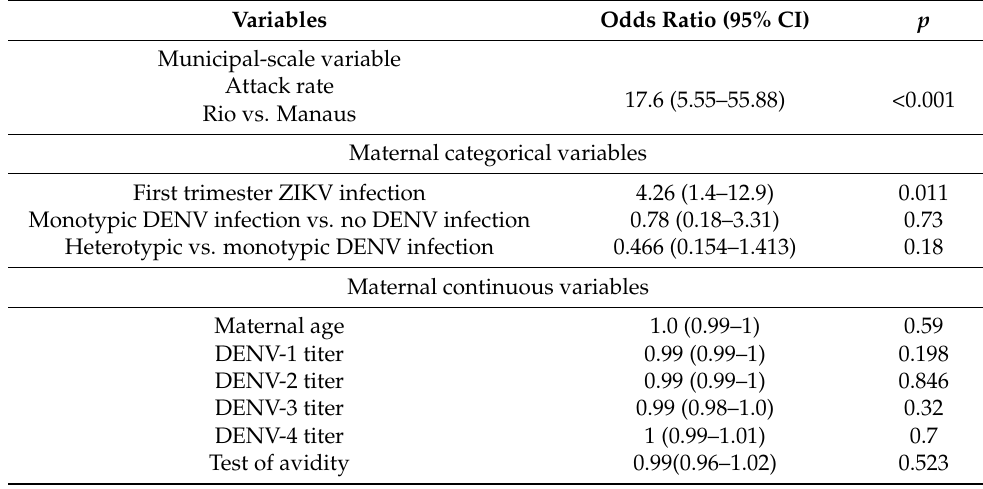
Table 4. Multivariate logistic regression of predictors of infant abnormalities at birth ( N = 114).